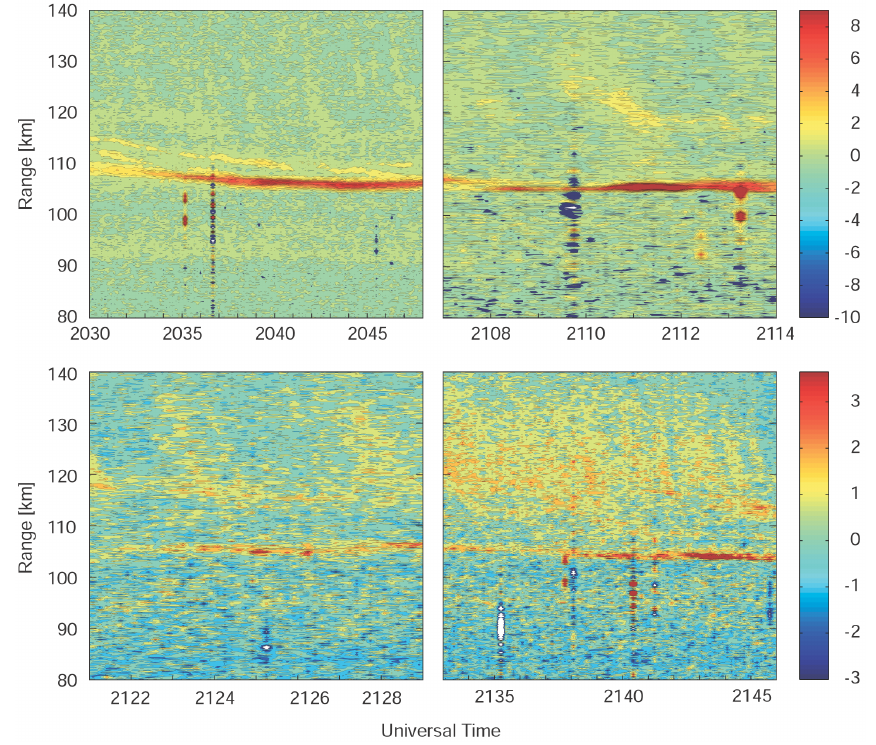
Fig. 5. The real part of the 30- µ s lag of the autocorrelation function during four time intervals with a 150-m gate separation and a 10-s time